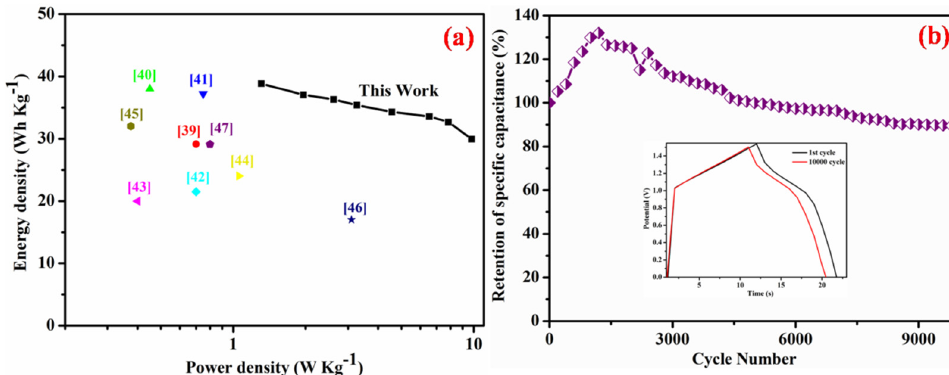
Figure 5. ( a , b ) Ragon plot and cyclic stability study of the device (inset of figure b is the GCD curve at 1st and 1000 cycles).